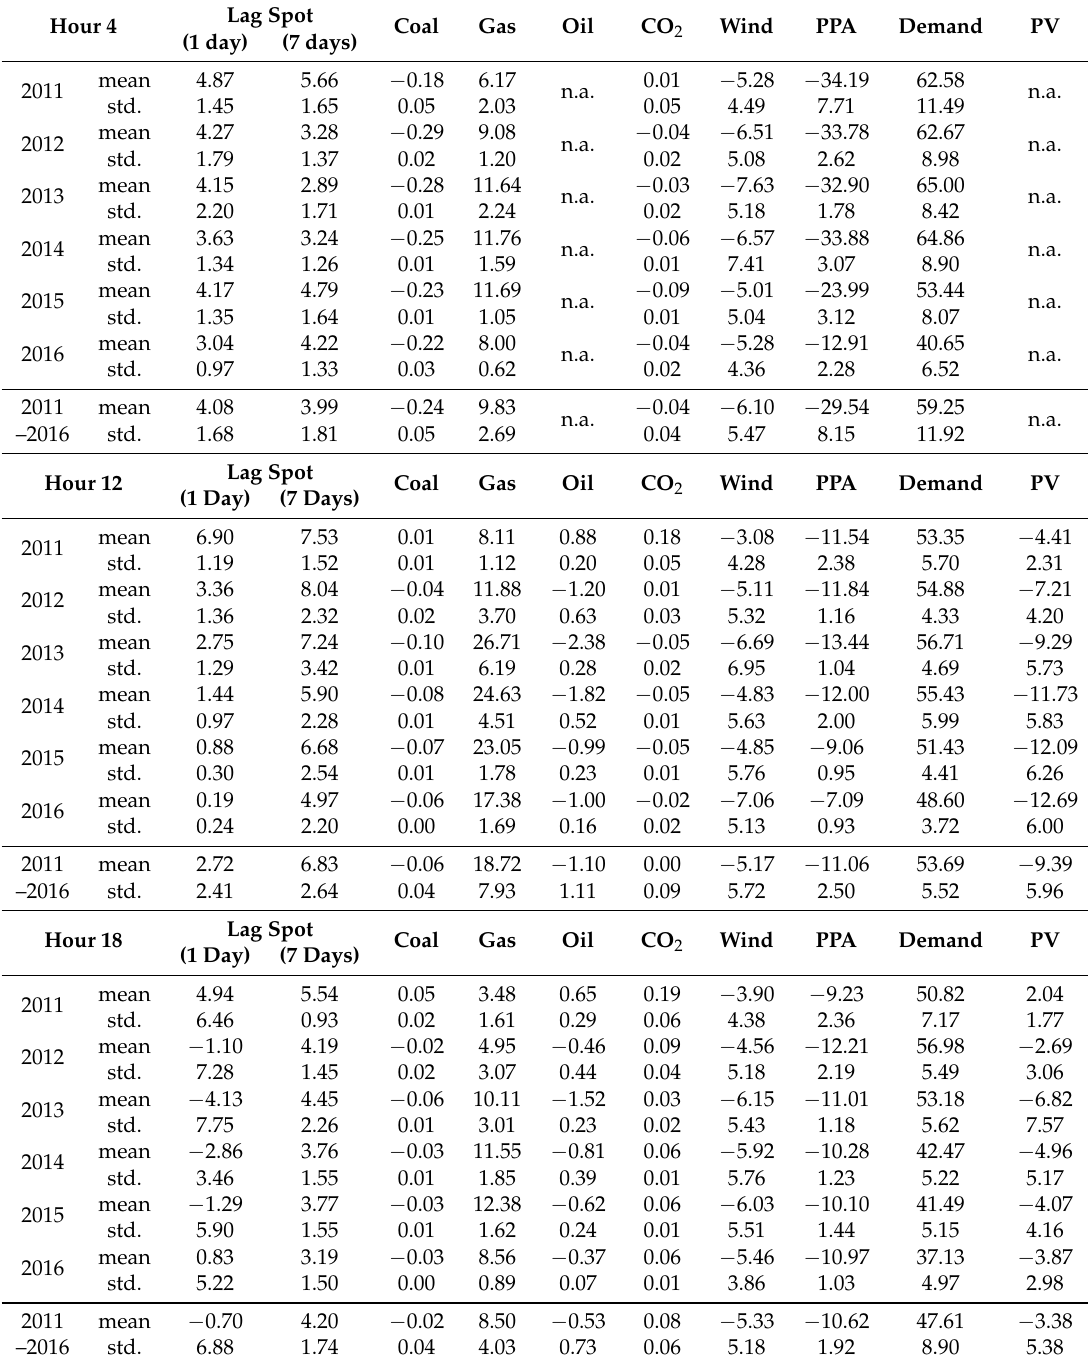
Table A2. Means and standard deviations of the marginal effects in EUR/MWh per year and for the whole sample period for weekend